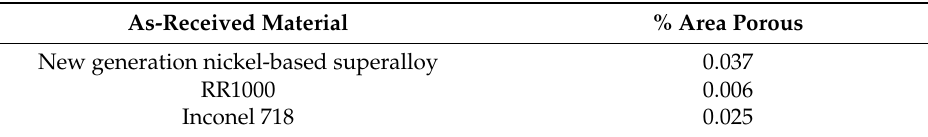
Table 3. Base material porosity.